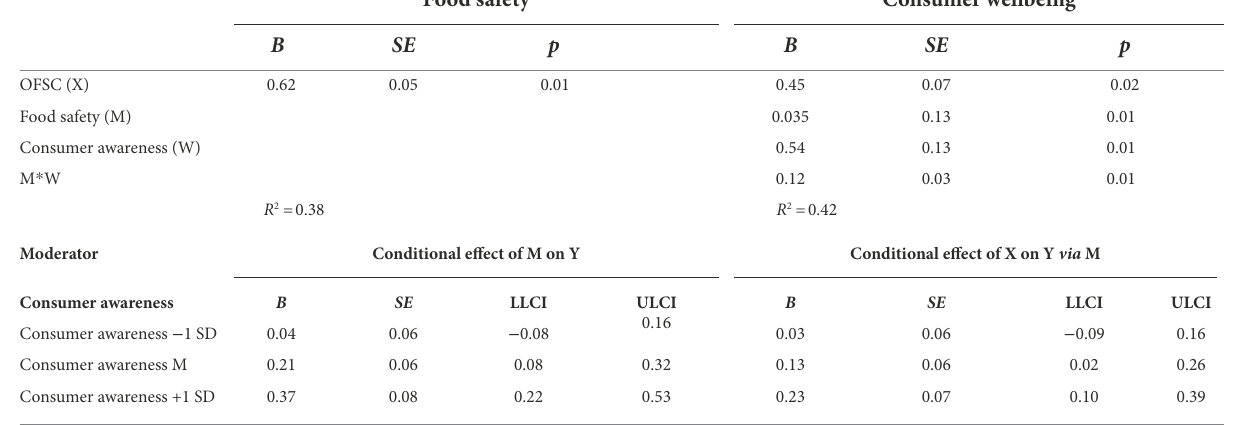
TABLE 5 Mediated-moderation